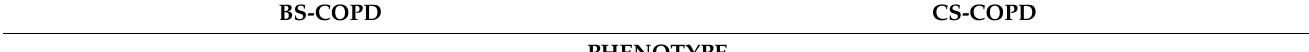
Table 7. Pathobiology of biomass smoke-related COPD compared to cigarette smoke-related COPD. BS-COPD